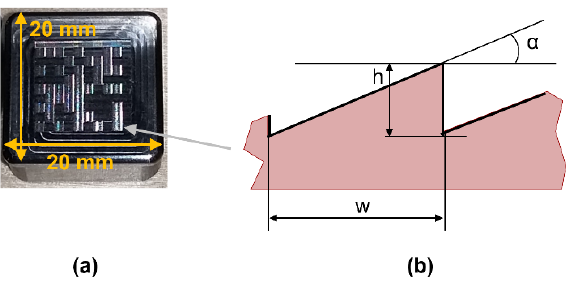
Figure 3. Mirroring of geometry throughout process steps.